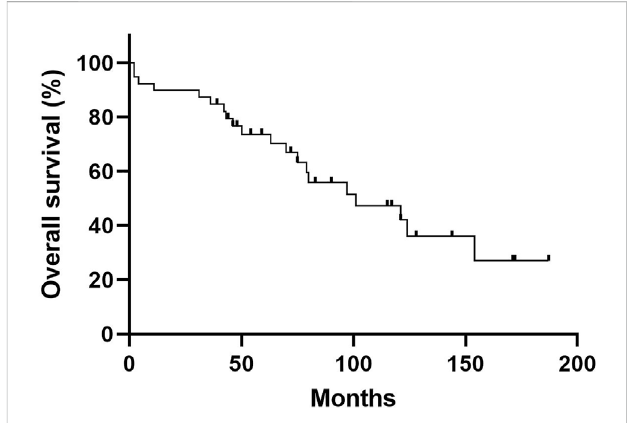
FIGURE 1 Overall Kaplan — Meier survival curve of patients with MPA-ILD. The 5-